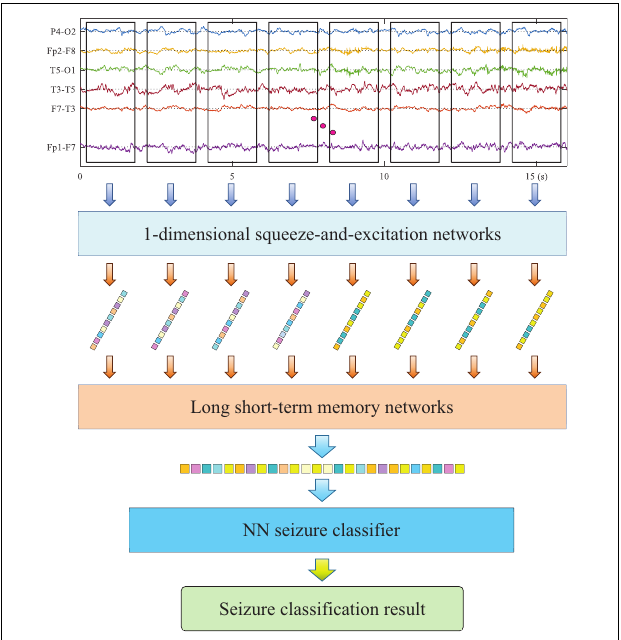
FIGURE 1 | The architecture of the utilized hybrid deep networks